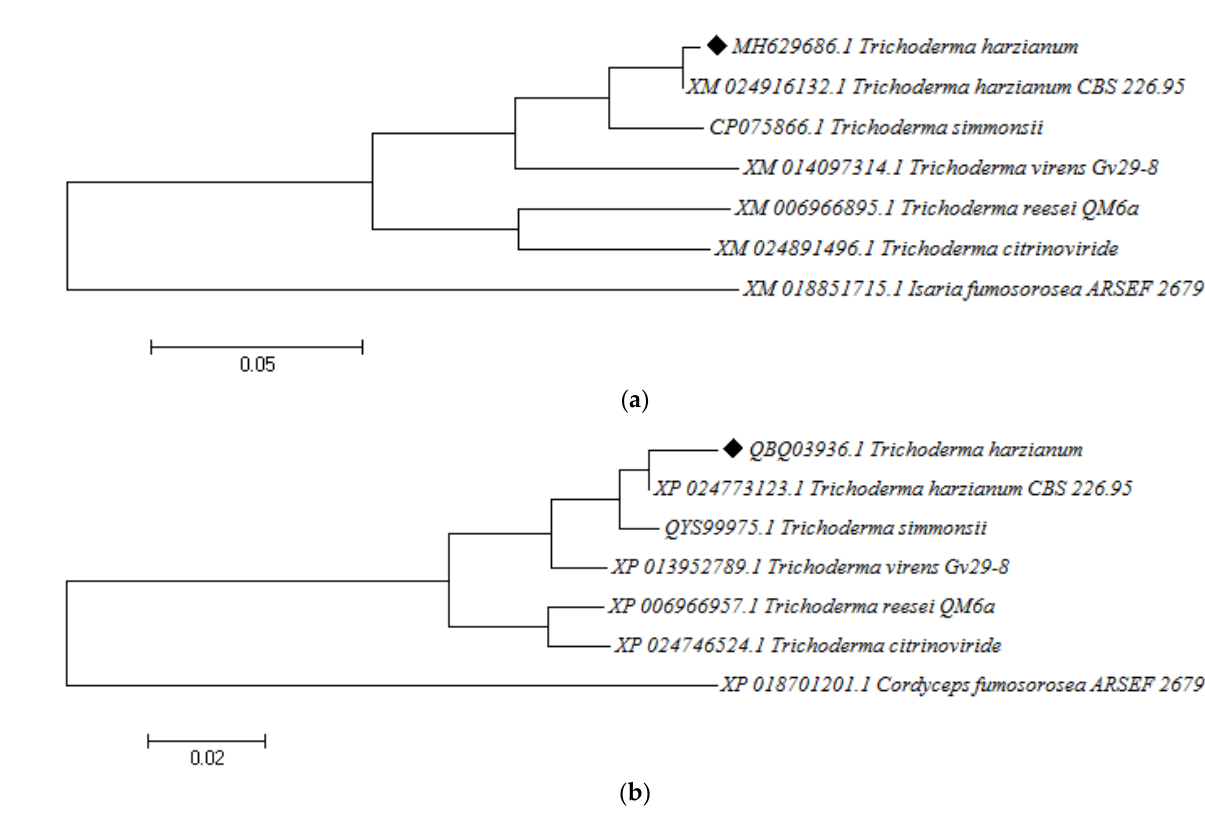
Figure 5. The phylogenic tree of the cyanide hydratase gene ( a ) and protein ( b ) from indigenous T. harzianum and four Trichoderma species, using Mega6 software.